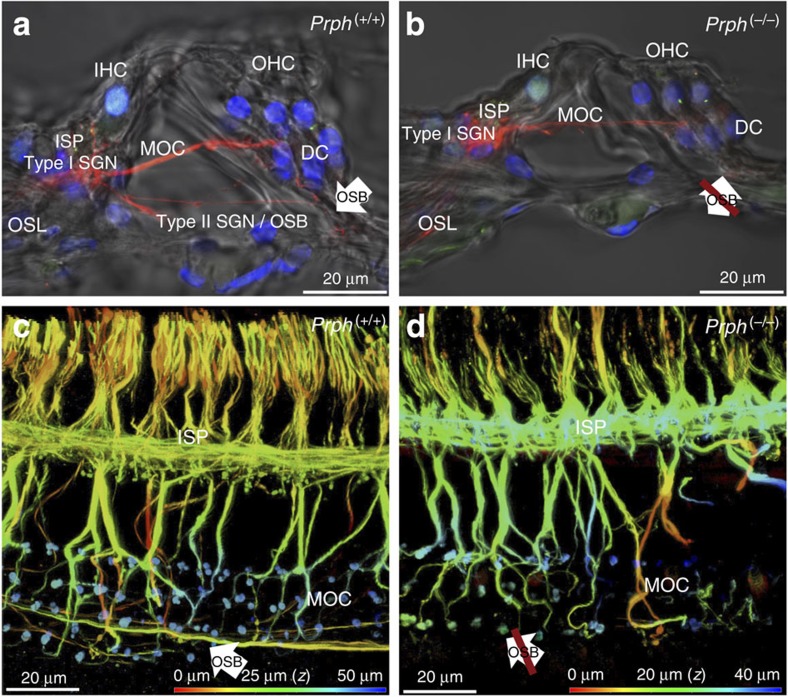
Loss of afferent innervation of outer hair cells (OHC) in Prph(−/−) cochlea.(a) Type II spiral ganglion neuron (SGN) outer spiral bundle (OSB) innervation of the OHC runs alongside the Deiters' cells (DC) and is resolved in adult Prph(+/+) organ of Corti via neurofilament 200 kDa immunofluorescence (red). This immunolabelling (confocal optical slice with transmitted light overlay) of a cryosection (50 μm) through the organ of Corti also identifies the medial olivocochlear (MOC) efferent fibres crossing the tunnel of Corti to innervate the OHC. CtBP2 immunofluorescence (green puncta) labels the presynaptic ribbons at the base of the OHC nuclei and at the inner spiral plexus (ISP) region of the inner hair cell (IHC) (the IHC nucleus is also labelled by this antibody). Blue fluorescence is DAPI nuclear staining. OSL, osseous spiral lamina. (b) Neurofilament 200 kDa immunofluorescence image of adult Prph(−/−) organ of Corti in a cryosection, as for a, showing the absence of the type II SGN innervation of the OHC via the OSB. (c) The type II SGN OSB fibres were more fully resolved in the adult Prph(+/+) organ of Corti mid-cochlear level whole mount via the neurofilament immunofluoresence (three-dimensional reconstruction of optical slices imaged from the basilar membrane; colour coded for depth (z)). Multiple fibres are shown crossing the floor of the tunnel of Corti, to enter the OSB and turn basally in parallel tracks (arrow). Deeper in the tissue, the MOC efferent fibres project to the OHC, terminating with bulbous synaptic boutons (VAChT immunolabelling; green–blue). (d) OSB fibres were absent in the adult Prph(−/−) organ of Corti (crossed arrow); whole mount as for c. Note the retention of the MOC innervation to the OHC.